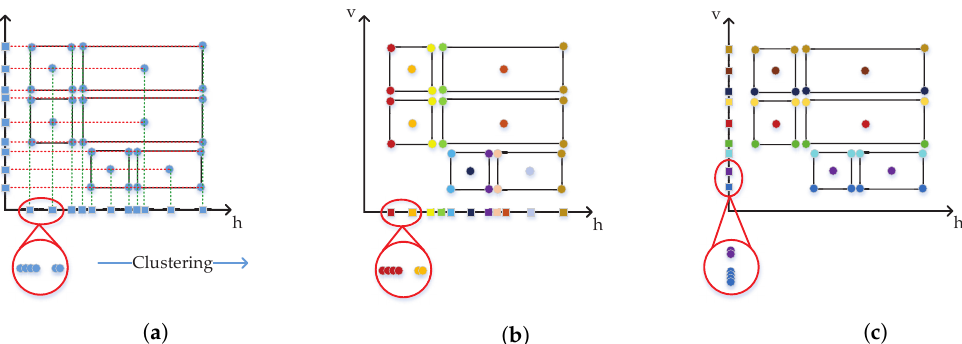
Figure 4. Detection of alignment rules. ( a ) Projection of points on vertical and horizontal directions independently; ( b ) Clustering projection points on the horizontal direction; ( c ) Clustering projection points on the vertical direction. For clarity, the projection points (as shown in the red circle) are represented by squares on the axes. Colors in ( b , c ) represent different